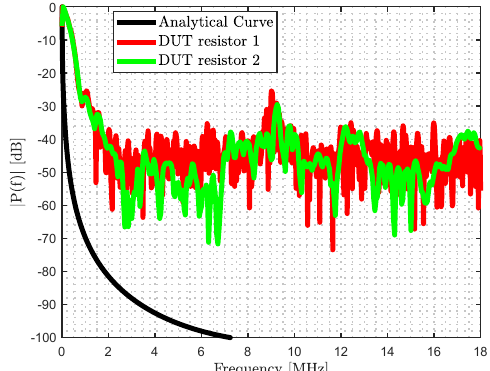
FIGURE 11. Spectra of the induced voltages at the load resistors and the analytical pulse. Results normalized to their maximum